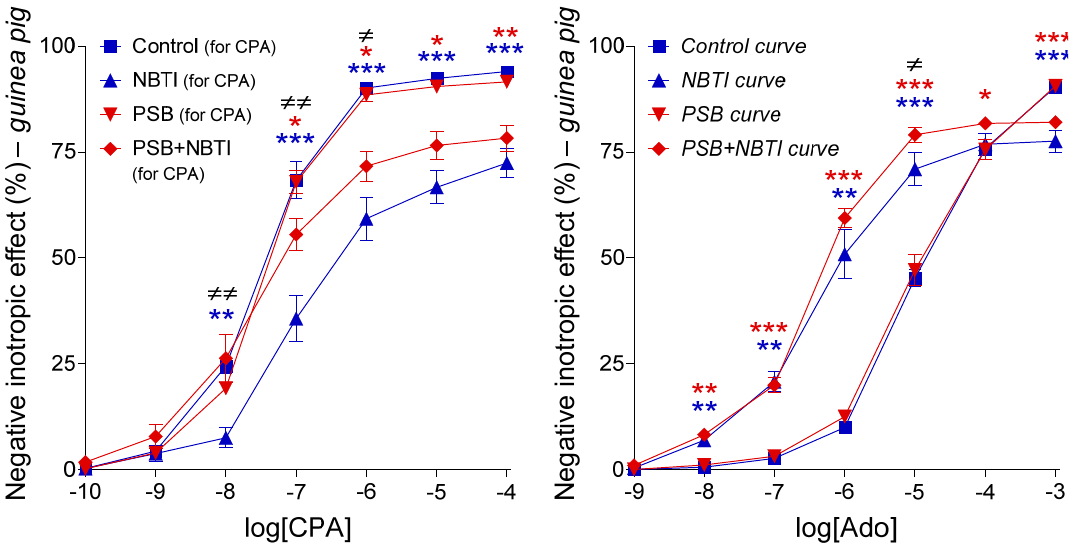
the groups labeled with “for Ado”). The left panel denotes the first adenosine E/c curve of all groups (for the groups labeled with “for CPA”, this is the only adenosine E/c curve, while in the case of the groups labeled with “for Ado”, this is the so-called control curve). Atria producing the first adenosine E/c curve were handled uniformly, so the group names refer to subsequent in vitro treatments. The right panel presents the first and third adenosine E/c curves of the groups labeled with “for Ado” separately. The x -axis shows the common logarithm of the molar concentration of adenosine (in the bathing medium), and the y -axis denotes the effect (as a percentage decrease in the initial contractile force). The symbols indicate the responses to adenosine averaged within the groups ( ± SEM). The color code used for the E/c curves in the right panel is the same as seen in Figure 6 (blue and red colors refer to the absence and presence of PSB-12379, respectively). Kind of E/c curves provided by groups labeled with “for Ado” is indicated in italics. E/c: concentration–effect; Ado: adenosine; CPA: N 6 -cyclopentyladenosine; NBTI: S -(2-hydroxy-5-nitrobenzyl)-6-thioinosine; PSB-12379: disodium